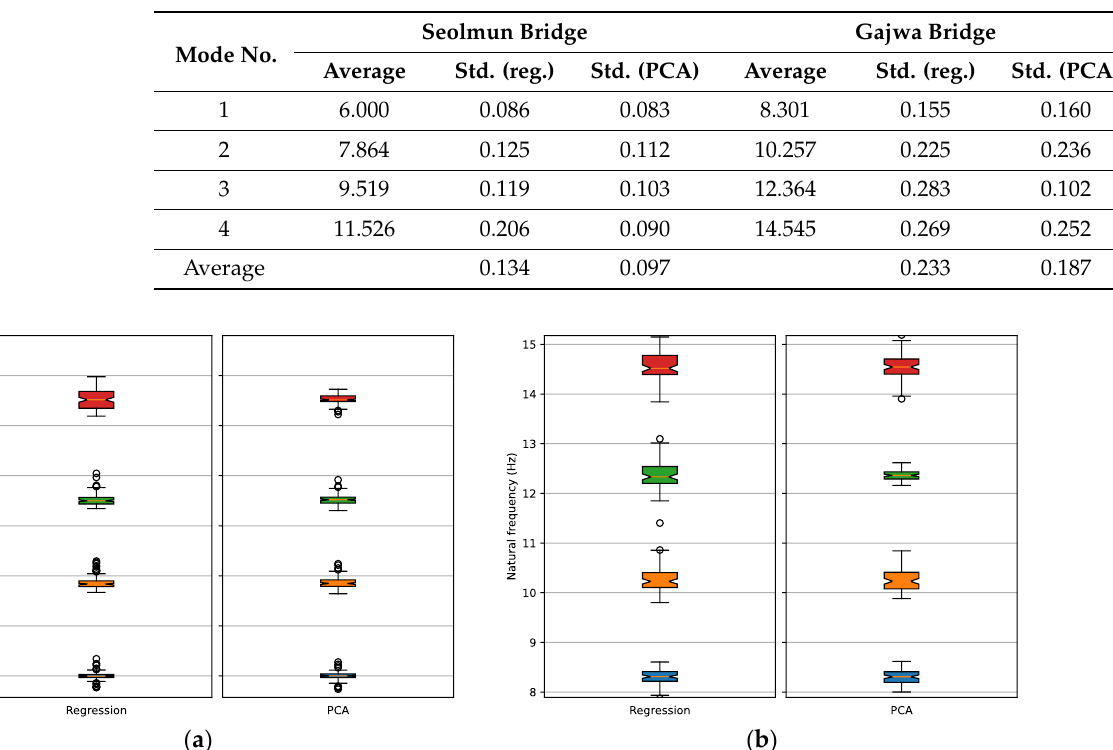
Table 1 . Modes other than the temperature effect (in Hz). Table 1. Modes other than the temperature effect (in Hz).